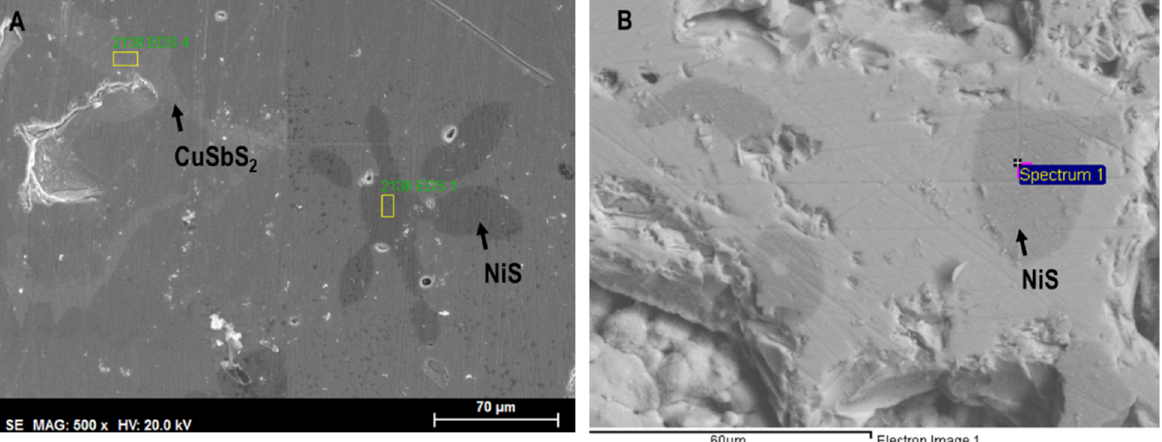
Figure 7. SEM backscattered images of ( A ) as-cast Cu 10.5 Ni 1.5 Sb 4 S 11.5 Se 1.5 sample, with the lighter toned CuSb(S,Se) 2 phase and the dark (Cu,Ni) x S y stars; ( B ) annealed Cu 10.5 Ni 1.5 Sb 4 S 11.5 Se 1.5 sample with a dark toned (Cu,Ni) x S y phase.